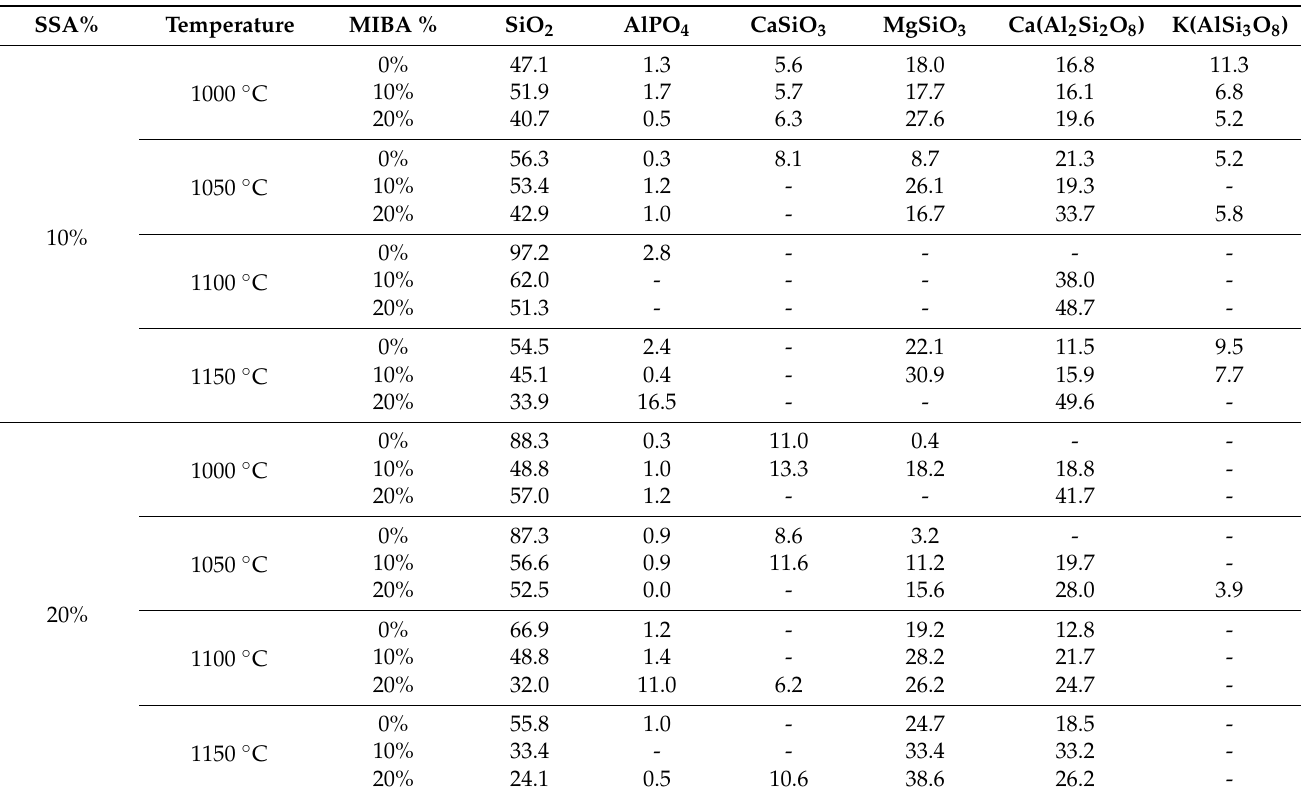
Table 4. XRD of 10%, 20% SSA, and 0% to 20% MIBA at various kiln